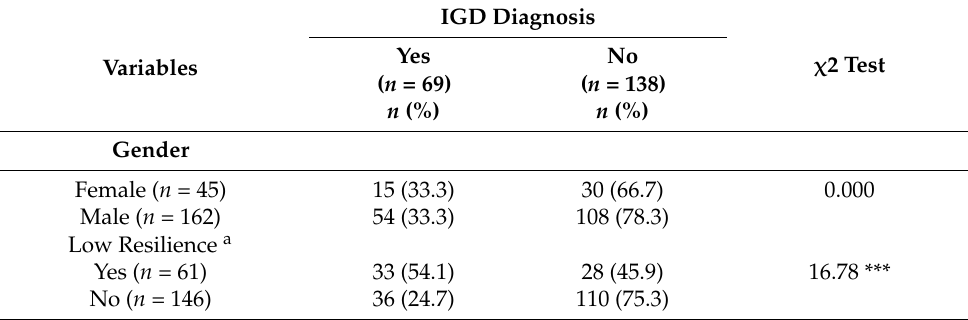
Table 1. The chi-squared analysis for the associations between gender, low resilience, and internet gaming disorder